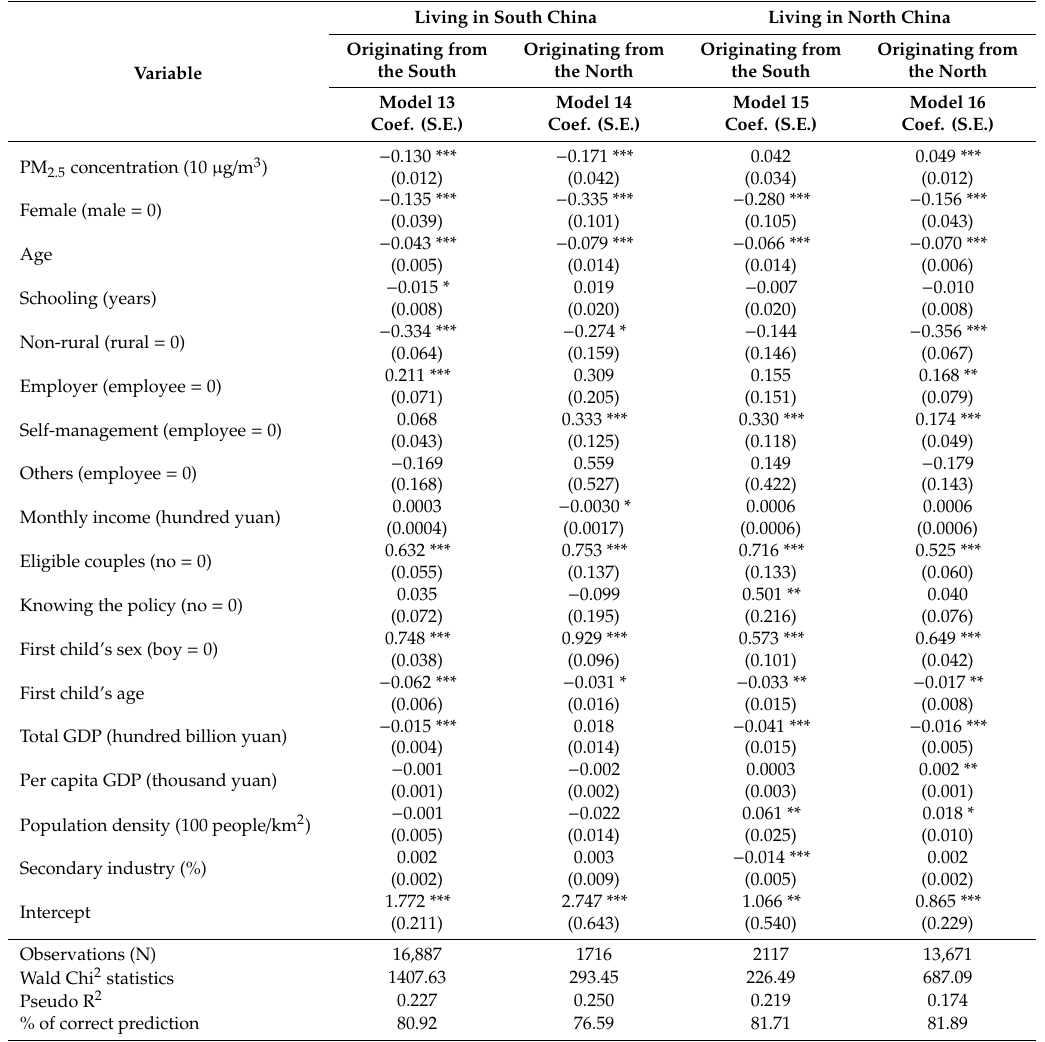
Table 4. Probit models: estimation of second birth intention of the floating population in south and north China. Variable